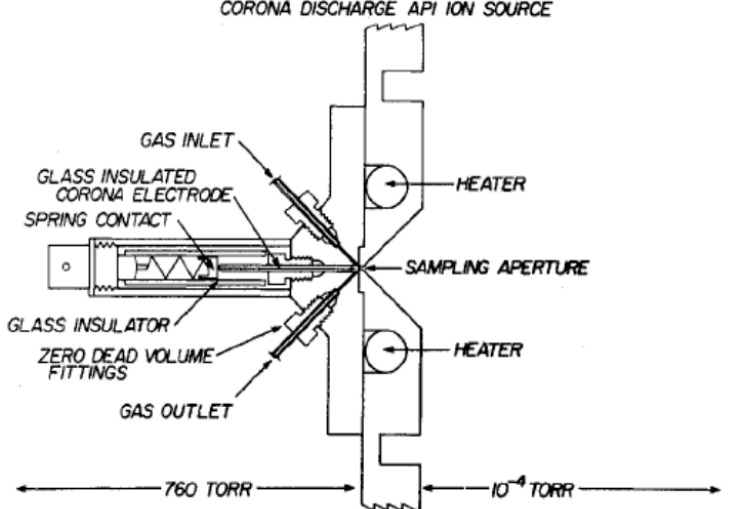
Figure 3. Schematic diagram of a corona discharge source with an adjustable distance between the corona discharge point and sampling aperture. Figure adapted from [35] with permission. Copyright 1976 American Chemical Society.